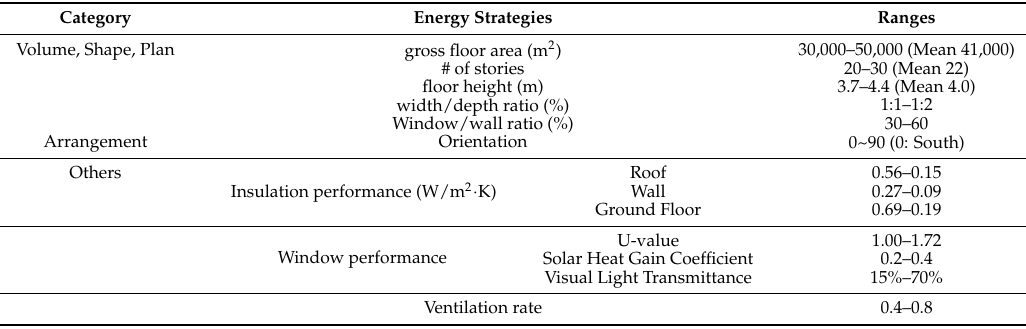
Table 3. Applicable ranges of the design